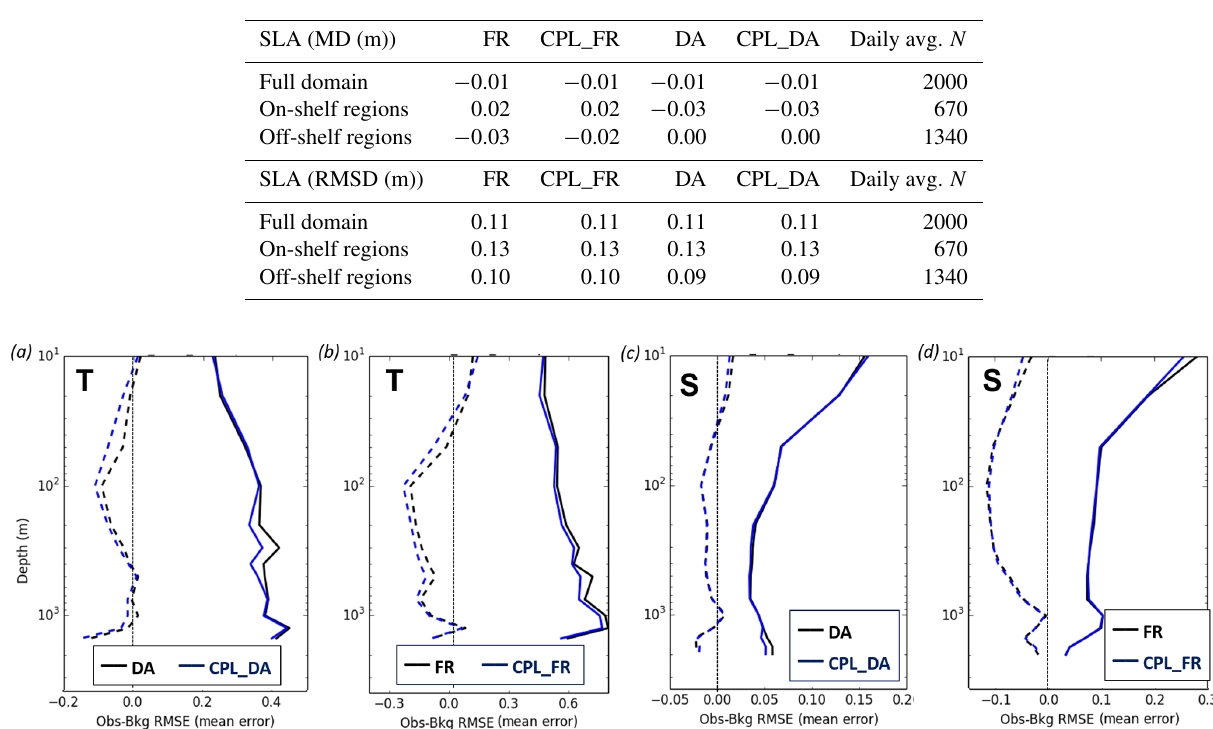
Table 3. SLA mean difference (MD = Model minus Observation) and root-mean-square difference (RMSD) statistics computed over the 2-year period (2016–2017) comparing each simulation experiment with satellite altimeter observations. Results are listed separately for the full model domain and discriminating between areas on-shelf and off-shelf.